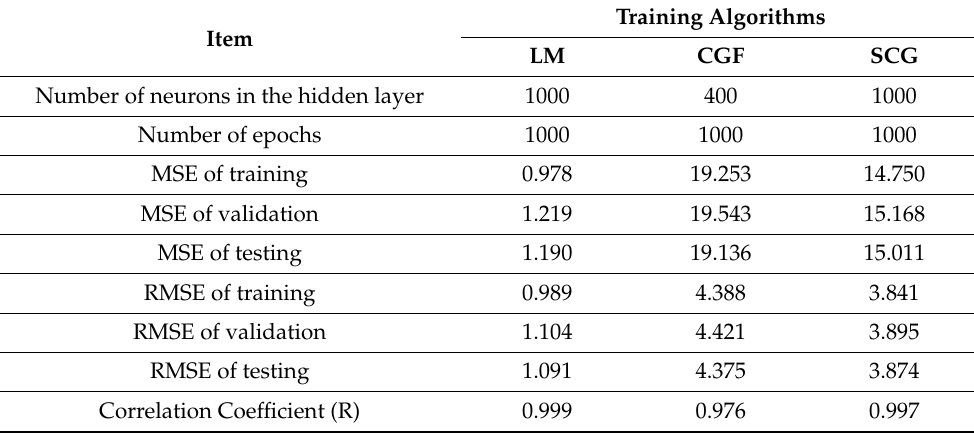
Table 5. Comparison between the learning algorithms used to train the proposed NFS